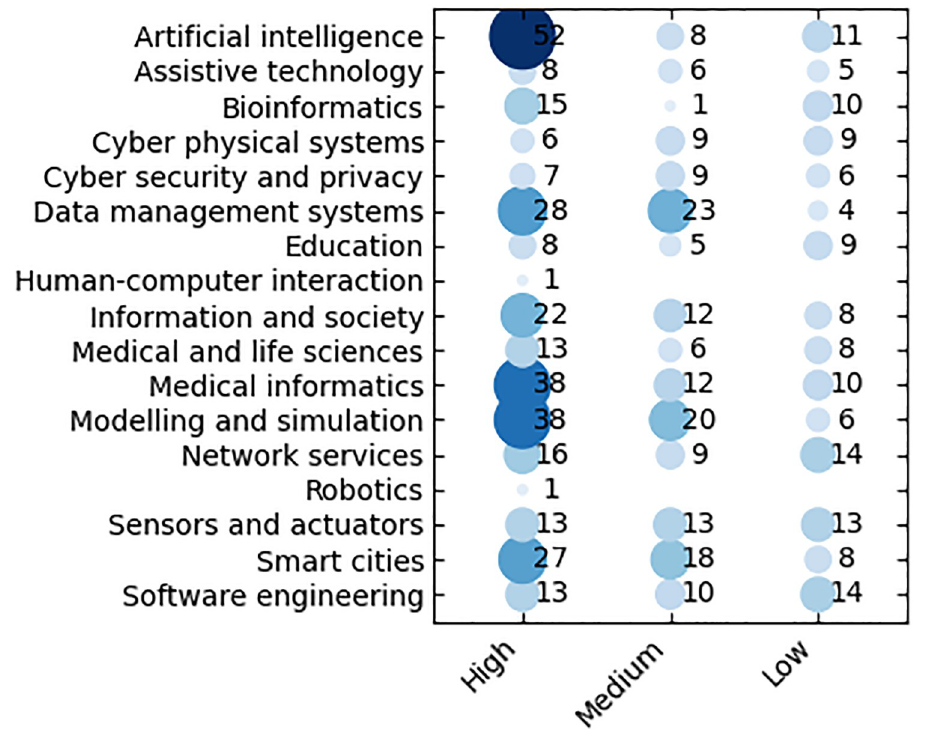
Fig 6. Number of activities per scientific domains with